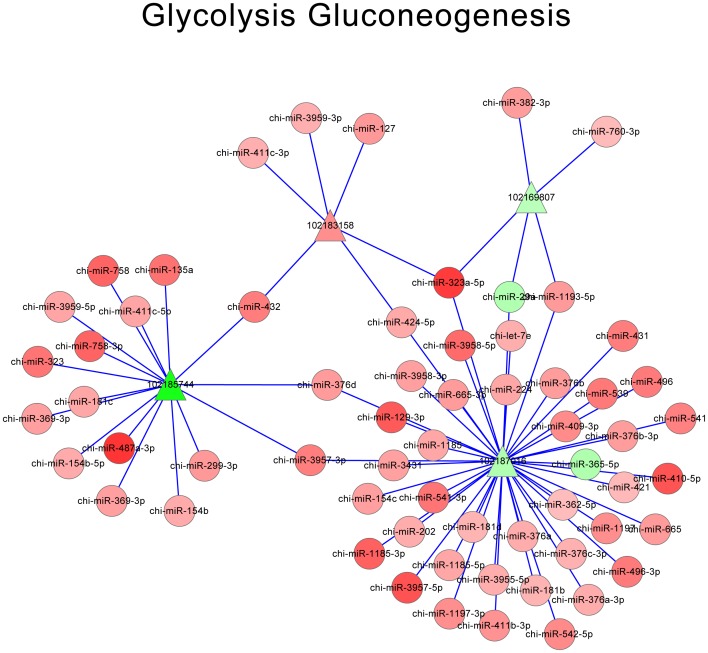
Network of glycolysis gluconeogenesis.Red triangle: up-regulated DE-targets; Green triangle: down-regulated DE-targets; Red roundness: up-regulated miRNAs; Green roundness: down-regulated miRNAs. The deeper the color, the stronger the trend.